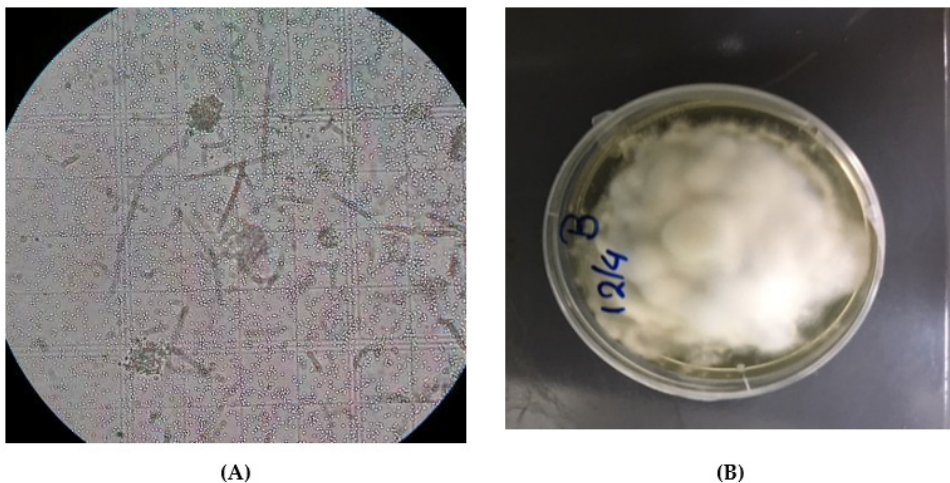
Figure 2. ( A ) Morphological identification of B. bassiana H2S32 from plant tissues and dead cadavers under ZEISS Primo Star (Carl Zeiss Microscopy GmbH, Germany) at 400× magnification, ( B ) B. bassiana H2S32 on plates with Sabouraud Dextrose Agar (SDA). Table 1. Molecular and Microscopic Identification from plant samples and T. confusum dead cadavers Blast ID Number, DNA, Sequence length, Conidia microscope evaluation, and Match percent.